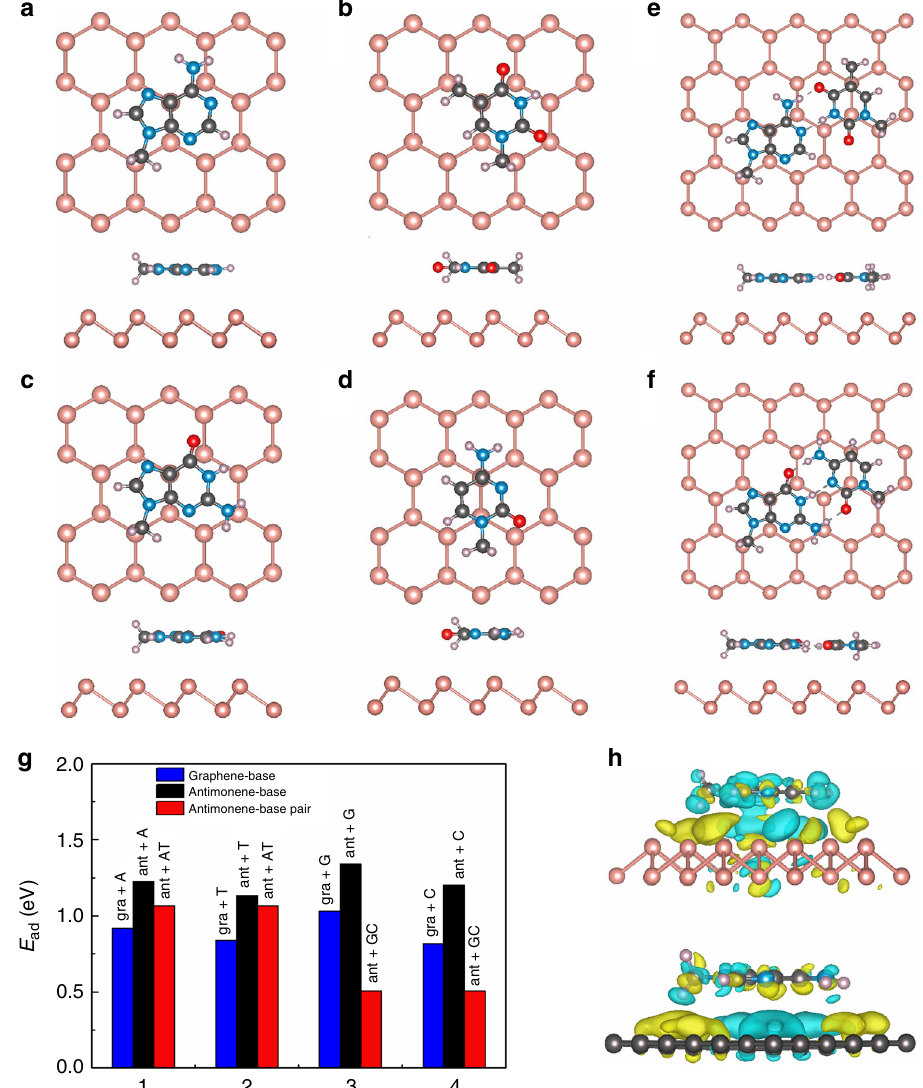
Fig. 1 Geometry and energies of adsorption systems. a Top and side views of the optimized structure of A nucleobases on antimonene. b Top and side views of the optimized structure of T nucleobases. c Top and side views of the optimized structure of G nucleobases. d Top and side views of the optimized structure of C nucleobases. e Top and side views of the optimized structure of A – T base-pairs on antimonene. f Top and side views of the optimized structure of G – C base-pairs on antimonene. g Adsorption energies of adsorbed nucleobases and base-pairs on antimonene and graphene. Blue bars respect to graphene + A, black bars respect to antimonene + A, red bars respect antimonene + A – T. h Side views of the charge density difference of the nucleobases on antimonene and